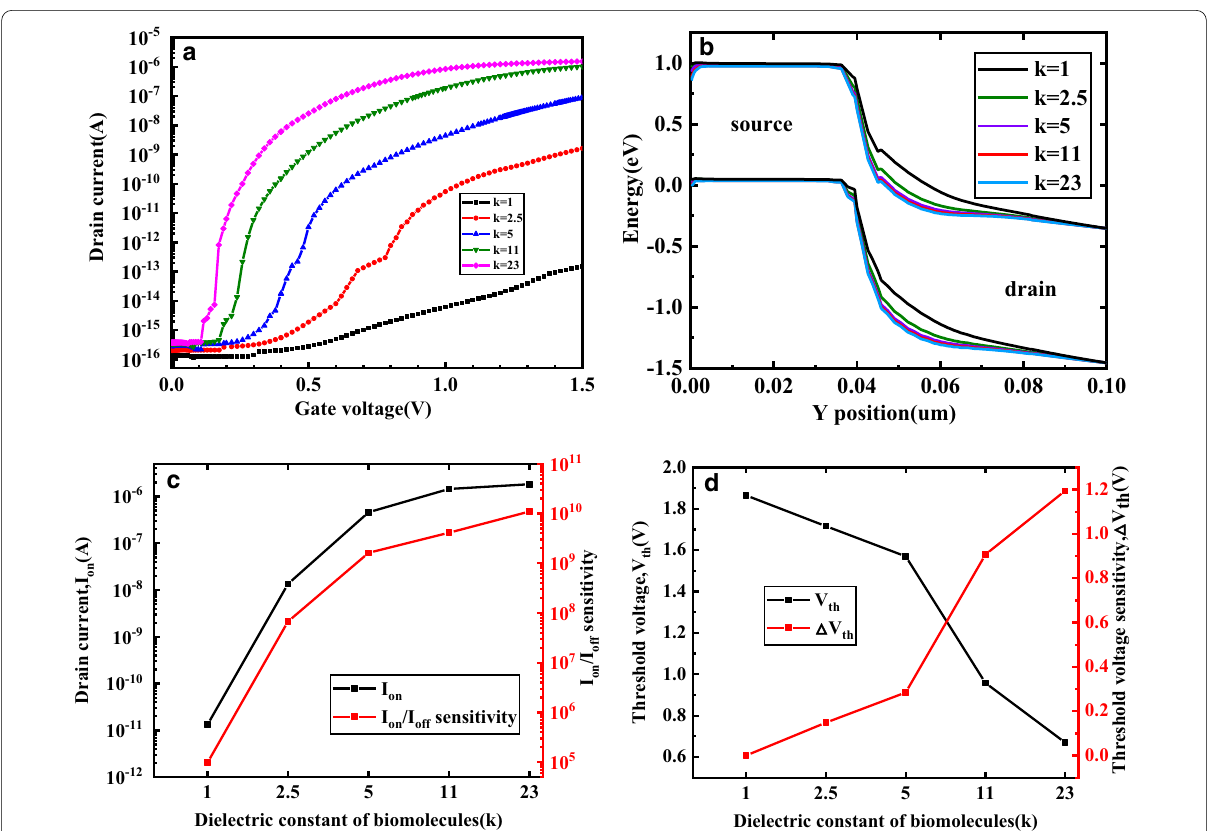
Fig.3 a Transfer characteristics, b energy bands variation with respect to the y axis, c I on / I off sensitivity and d threshold voltage sensitivity of DM-DSTGTFET biosensor for different values of k at V d